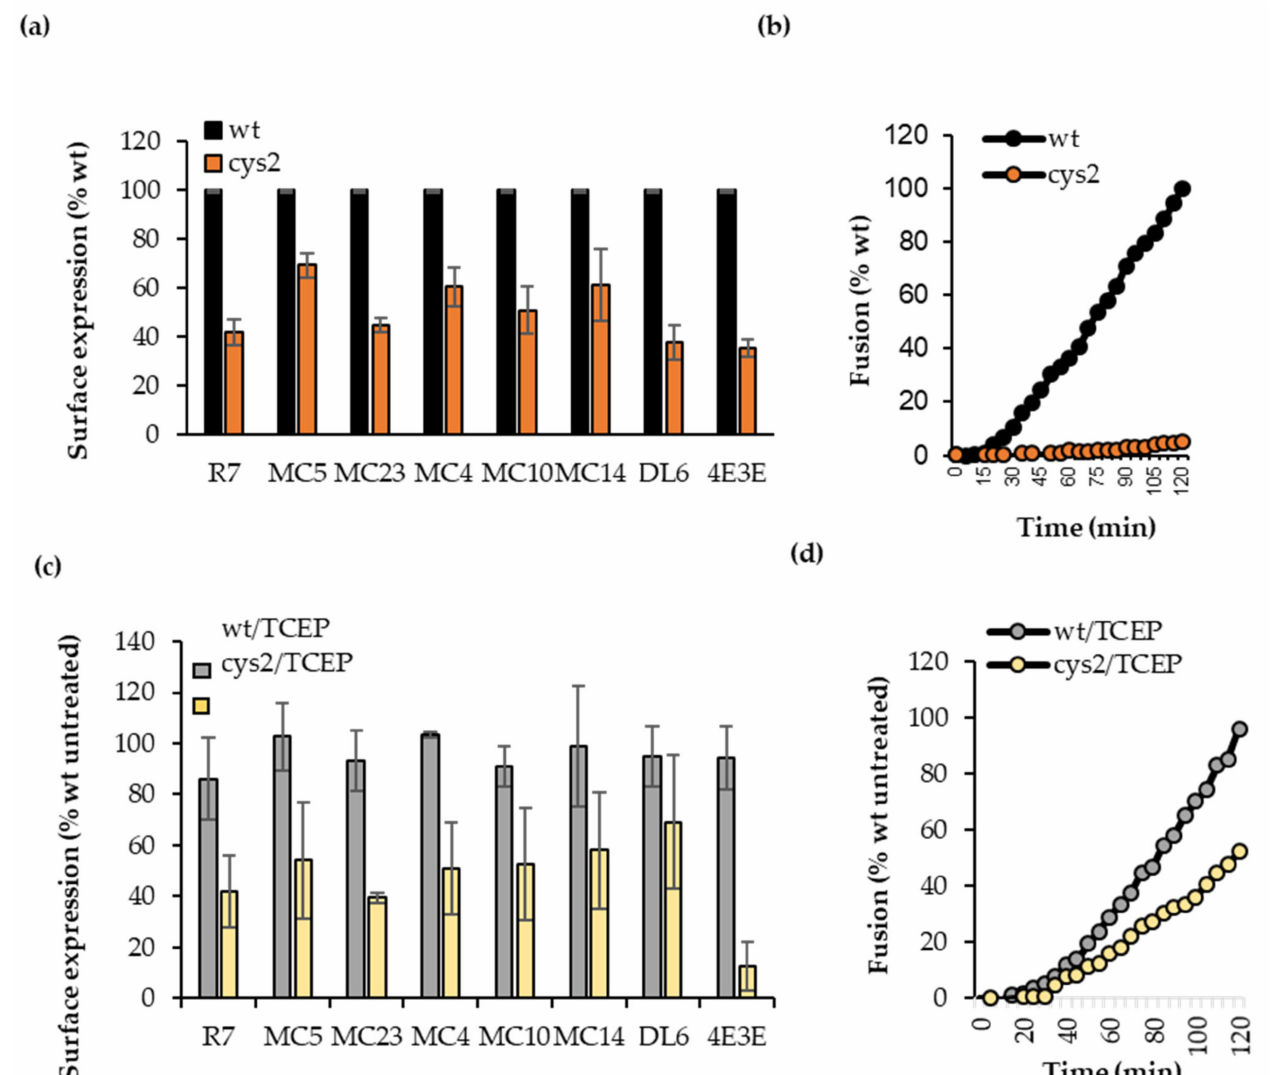
Figure 3. Characterization of wt and cys2 proteins. ( a ) CELISA of B78 cells transfected with full- length wt and cys2 gD and probed with select Mabs. Expression of cys2 (brown bars) is presented as % of binding to wt with the same antibody. The average of three experiments, each done in duplicate. ( b ) Fusion assay. Ability of full-length gD wt (black curve) and cys2 (brown curve) to trigger fusion in a live cell fusion assay. Data are presented as percent fusion by wt gD at the 2 h time point. Representative curve from three independent experiments, each done in duplicate. ( c ) CELISA after TCEP treatment. Binding of sentinel Mabs from each community to B78 cells transfected with full-length wt (gray) or cys2 (yellow) gD after cells were treated with TCEP for 10 min. Average of three experiments, each done in duplicate. Data for each antibody was normalized to no treatment wt samples. ( d ) Fusion assay. Effector cells expressing gB, gH/gL, and wt or cys2 gD were treated for 10 min with 10 mM TCEP before fusion was triggered by the addition of donor nectin-1 expressing cells. Data are presented as percent fusion by untreated wt gD at the 2-h time point, when the rate of fusion was at its maximum. Representative curve from three independent experiments, each done in